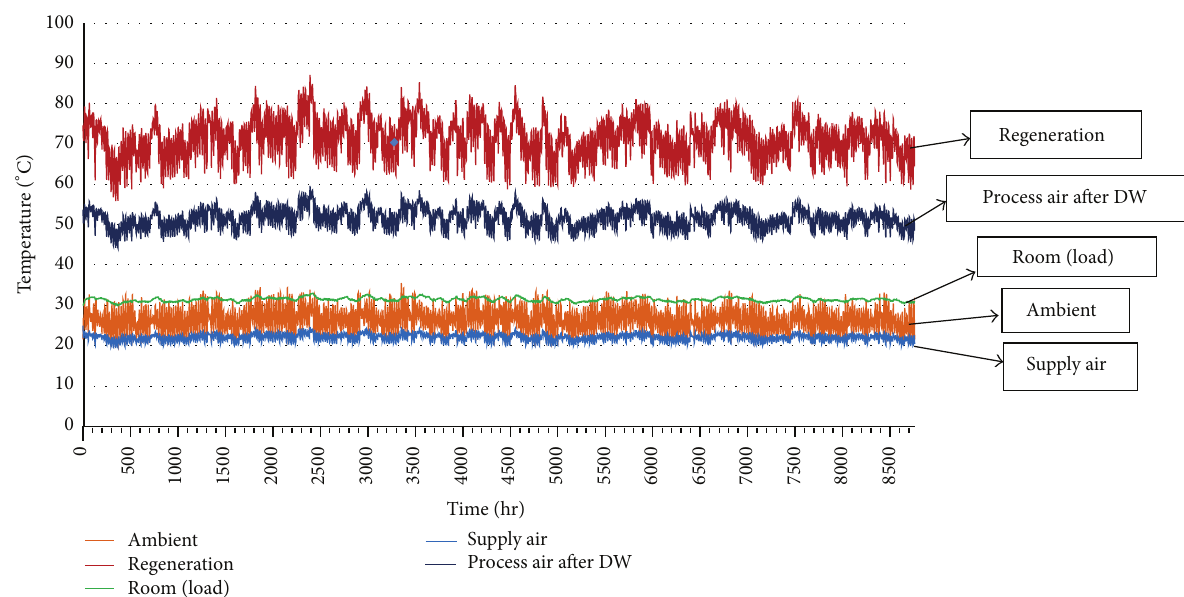
Figure 8: Temperatures ( ∘ C) of different components versus time (hr) in recirculation desiccant cooling